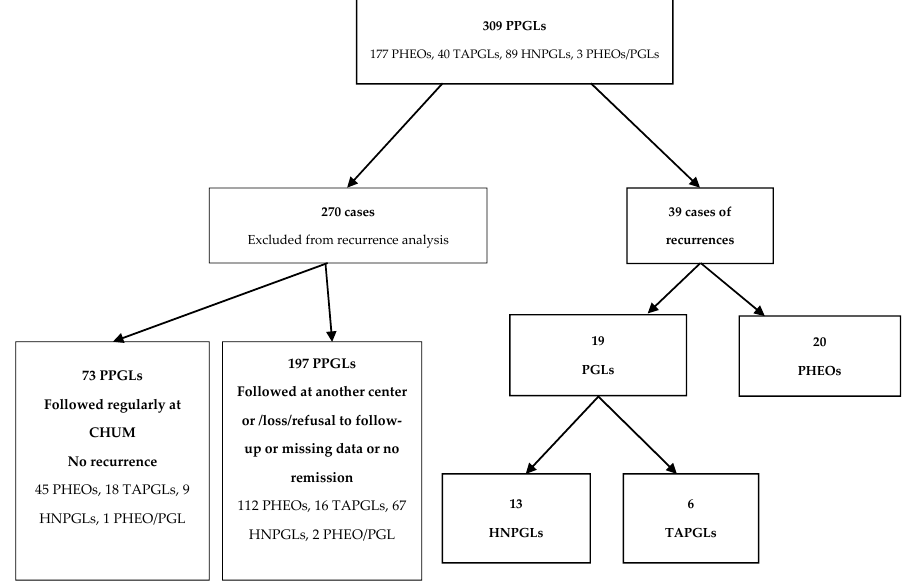
Figure 1. Flowchart representing the cohort of patients with PPGLs studied. Cancers 2022 , 14 , x FOR PEER REVIEW